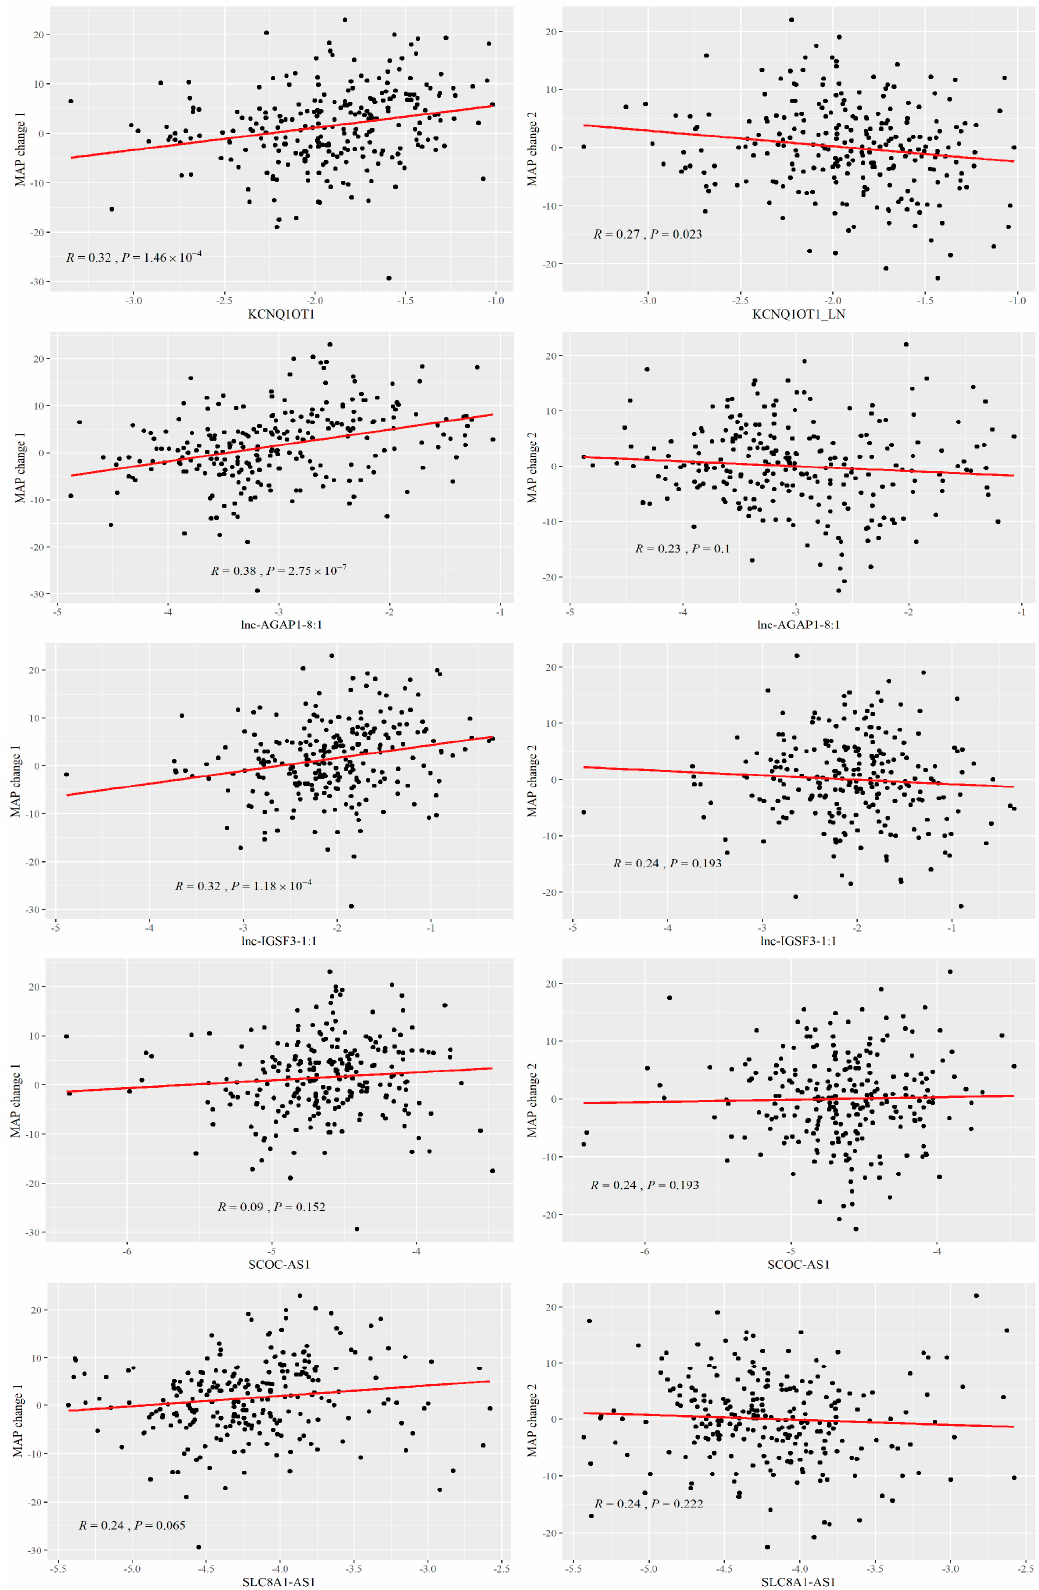
Figure 2. Linear regression analysis representing the association of lncRNAs with